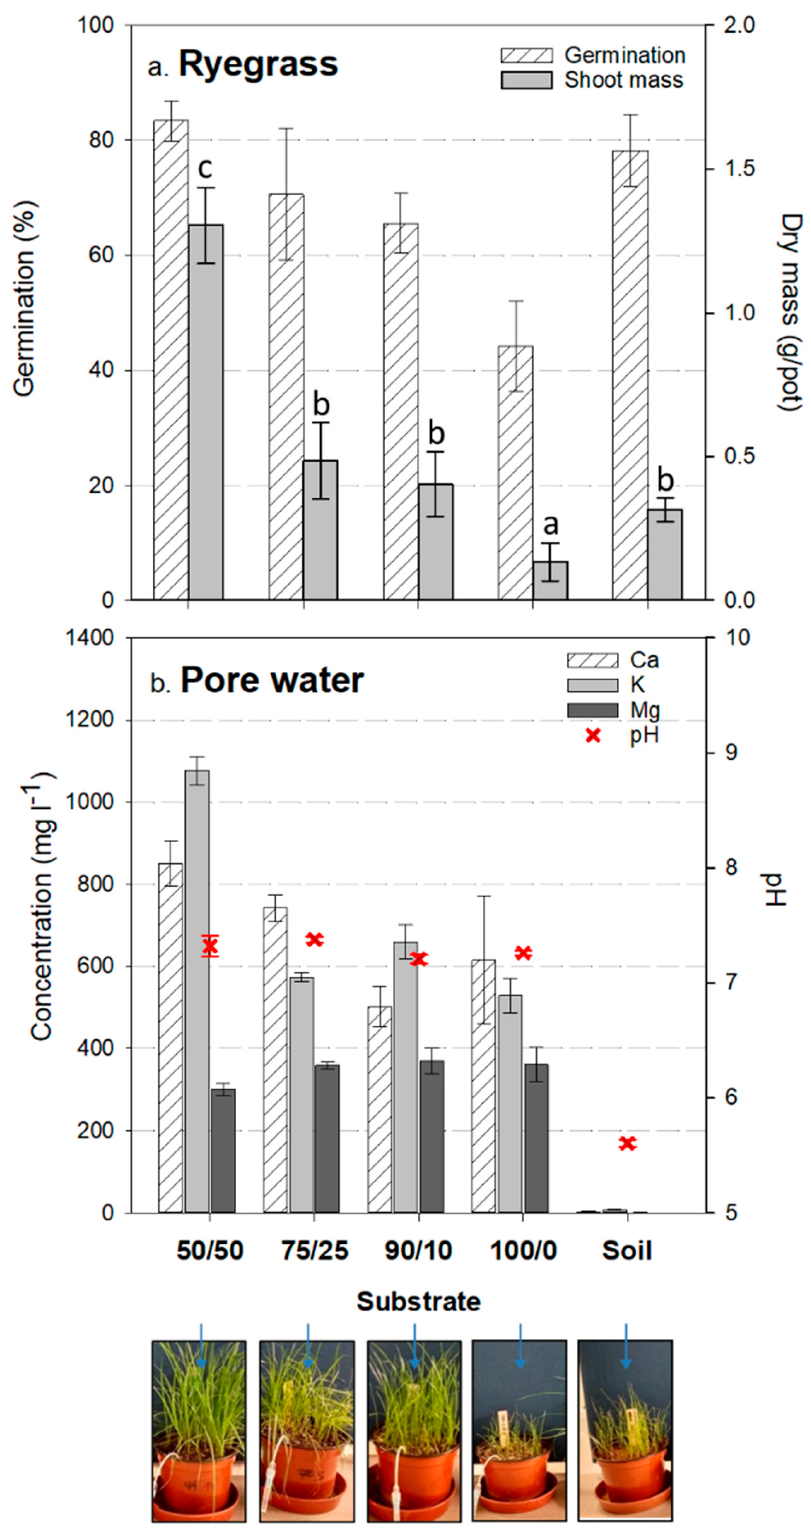
Figure 2. Pot experiment showing ( a ) Ryegrass germination (%) and shoot dry mass (g/pot) after 30 days; ( b ) Concentrations of Ca, K, Mg (mg L − 1 ), and pH in pore water samples collected at 30 days. Pictures below x-axis show typical ryegrass mass before harvesting. All values are mean (+/ − SEM), n = 10. Shoot mass bars with different letter above them indicate significant statistical differences.